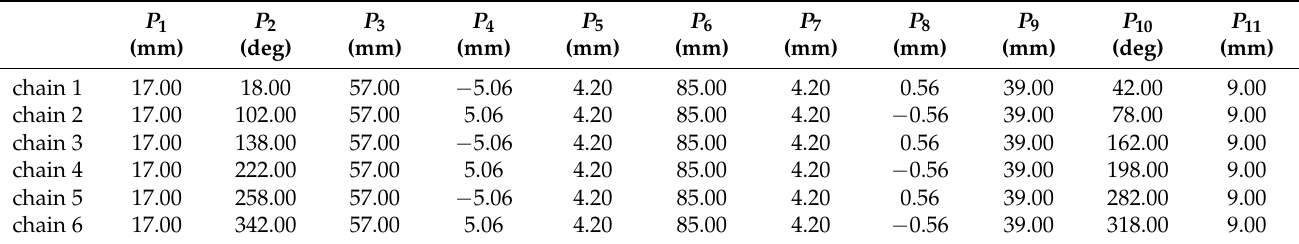
Table 1. Geometric parameters of all chains.